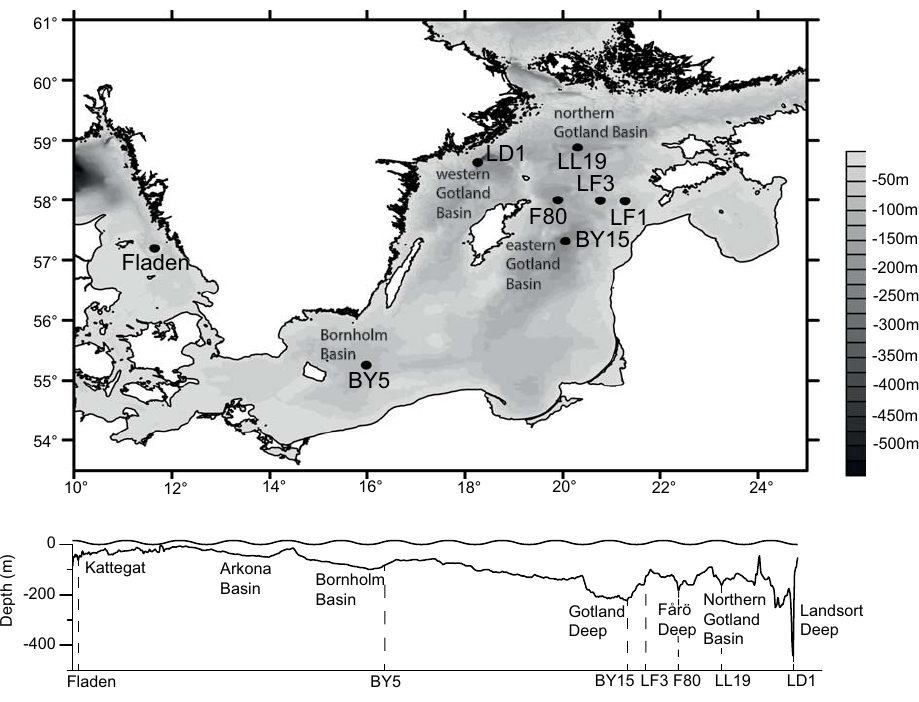
Figure 1. Bathymetric map and depth profile of the Baltic Sea showing the locations of the sampling sites.